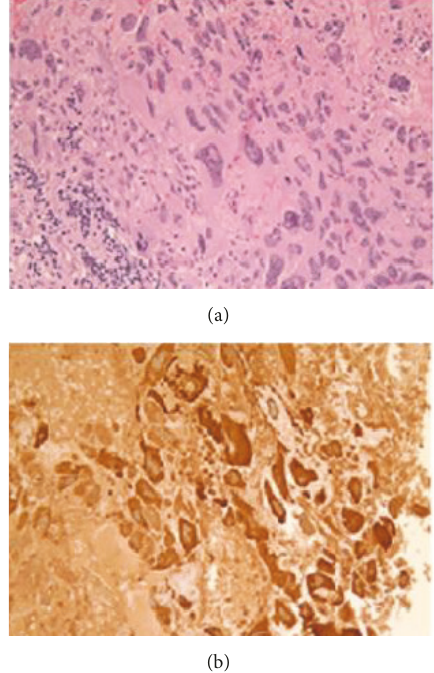
Figure 2: Brain biopsy. (a) Histologic examination of the biopsy reveals a sheet of syncytiotrophoblastic cells characterized by multi- lobulated to multinucleated and spindle shaped cells with a moder- ate amount of eosinophilic cytoplasm (H&E × 20). (b) Immunohis- tochemical stain for beta-hCG shows moderate to strong cytoplas- mic staining of the syncytiotrophoblastic cells ( × 20).